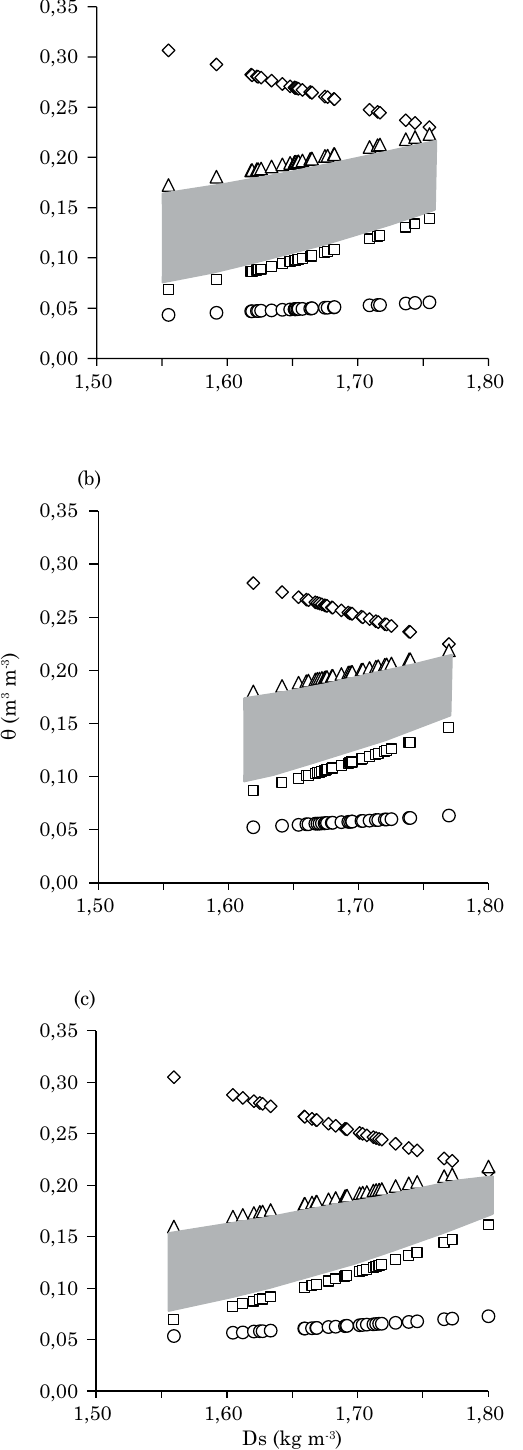
Figura 2. Conteúdo de água do solo (θ) em função da densidade do solo (ds) para as camadas de 0-10 cm (a), 10-20 cm (b) e 20-30 cm (c). As áreas hachuradas correspondem ao iHo para os limites críticos de -80 hPa (θ cc ), -15.000 hPa (θ pmp ), 2,5 MPa (θ rp ) e 0,10 m 3 m -3 (θ pa ).